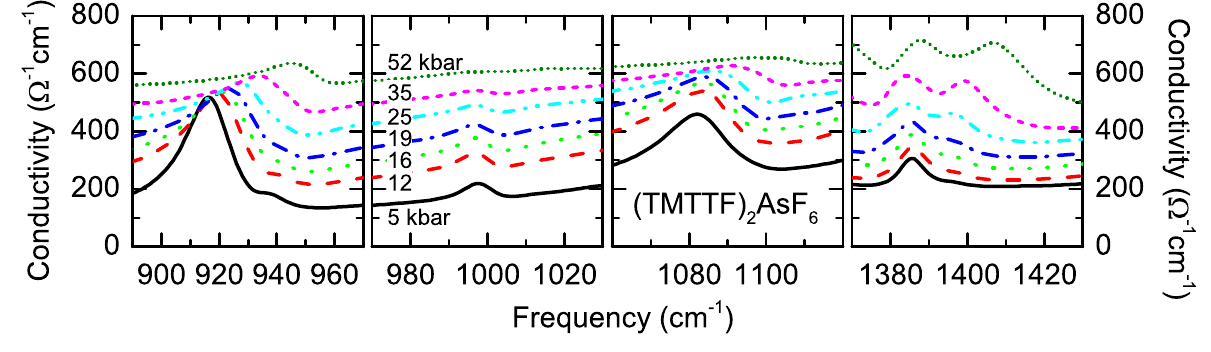
Figure 17. Pressure dependence of the optical conductivity of (TMTTF) room temperature for E (cid:107) a . The spectral range of those features is enlarged that are related to vibrations of the TMTTF methyl